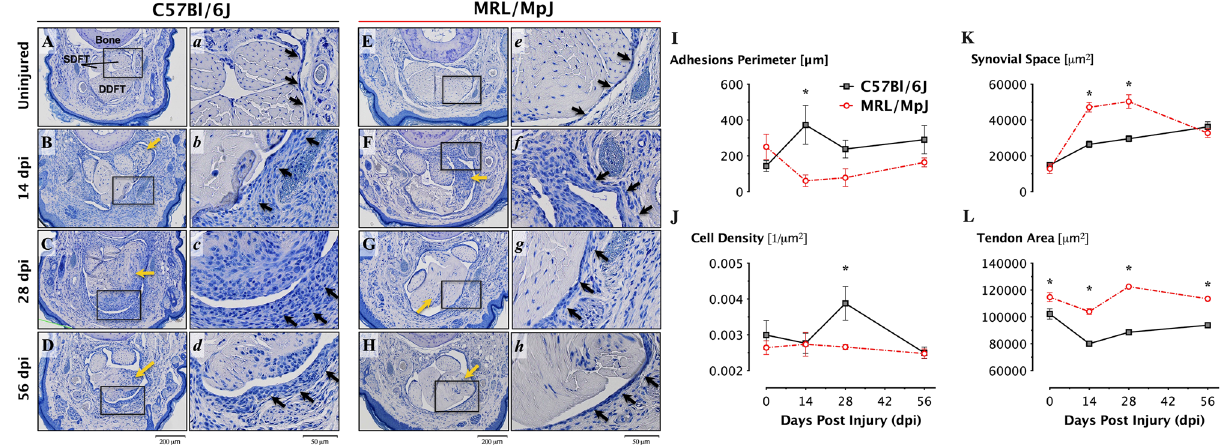
Figure 1. MRL flexor tendons heal with reduced peritendinous adhesions. Representative (2X) micrographs ( A – H ) of hematoxylin-stained cross-sections of the digits of C57 and MRL mice before and after zone II injury up to 56 days post injury (dpi). High magnification (×20) regions of interest ( a – h ) are representative of five levels analyzed per tendon. Black arrows identify the thin synovial sheath in uninjured tendons, and the hyperplasia that ensues immediately after injury in both strains. The synovial sheath hyperplasia appears to persist in the C57 tendons up to 56 dpi, but resolves in MRL tendons by 28 dpi. Yellow arrows indicate regions of increased cellularity in the injured tendon and peritendinous tissues evident by the punctate, intense hematoxylin staining. Histomorphometric quantification of the healing tendon shows reduced adhesions ( I ) and tendon hyperplasia ( J ), as well as increased synovial space ( K ) and tendon area ( L ) in the MRL mouse. The length of the tendon perimeter adhered to the subcutaneous tissue and cell density are significantly reduced at